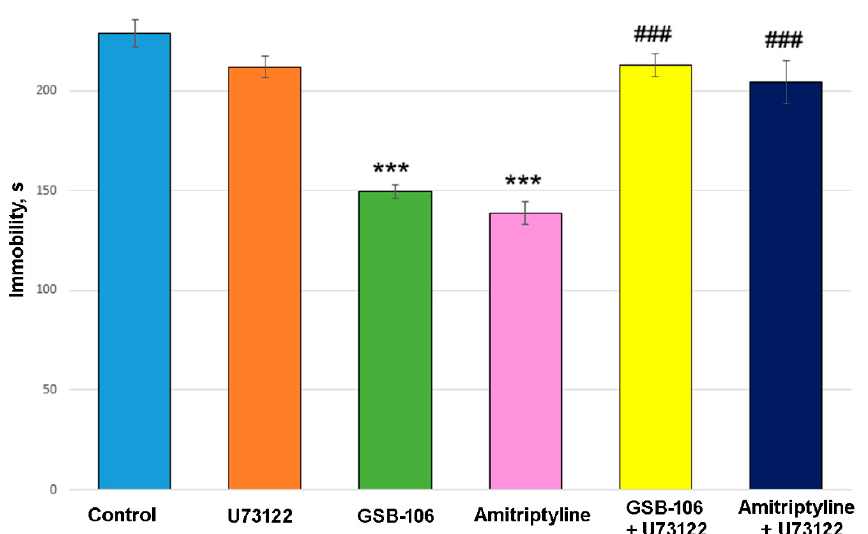
Figure 6. The PLC inhibitor U73122 blocks the antidepressant-like activity of the GSB-106 dipeptide and Amitriptyline in the forced swimming test in mice. *** p < 0.0001 statistical significance of differences compared to the “Control” group; ### p < 0.0001 statistical significance of differences compared to the “GSB-106” or “Amitriptyline” group (two-way ANOVA with Tukey’s post hoc test).